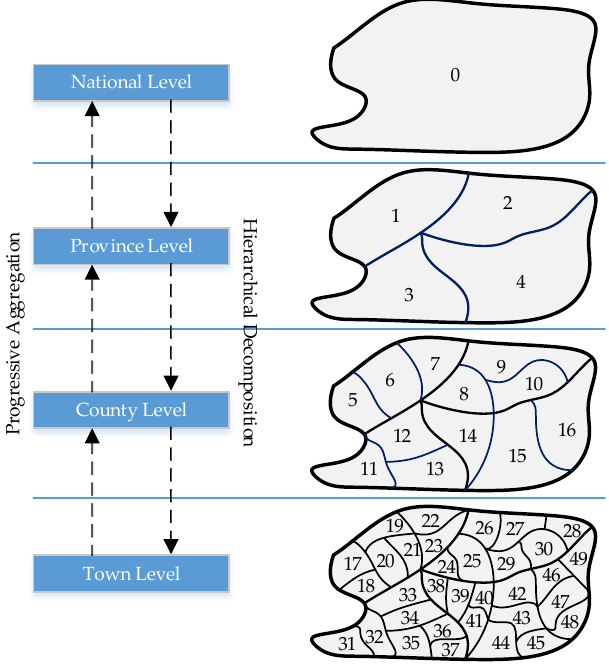
Figure 2. Administrative level decomposition in China (The numbers in these areas are unique Administrative level decomposition in China (The numbers in these areas are identifiers). unique